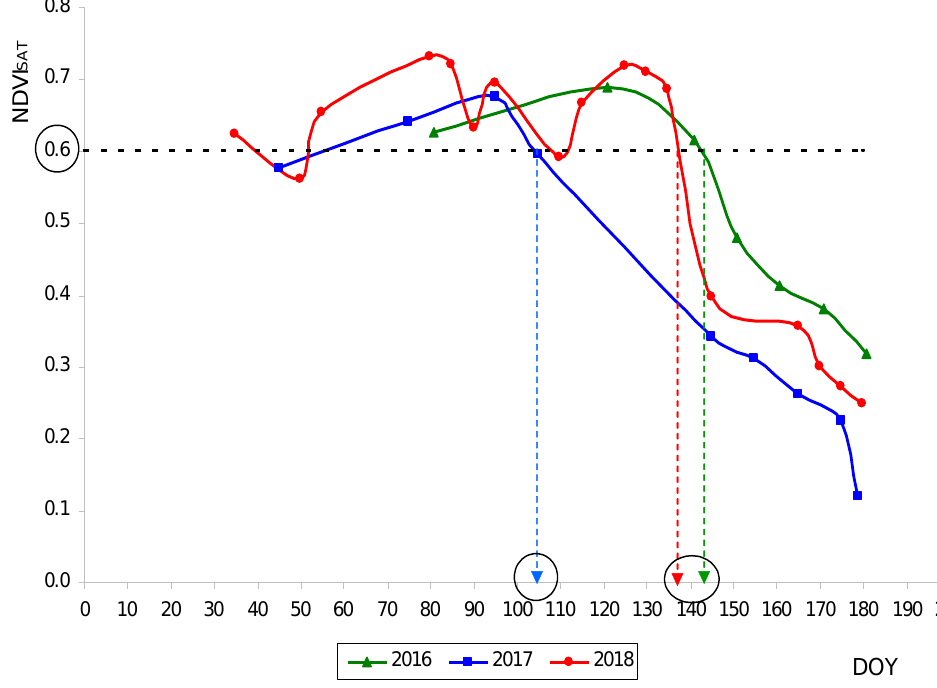
Figure 6. Reconstruction of historical vegetation index trends using time series records of satellite images (NDVI SAT ), retrieved between February and June 2016, 2017, and 2018, without the records affected by the existence of clouds. Data are average values of the twelve sampling points. Arrows indicate the moment in which, in each year, the abrupt fall of the NDVI below 0.6 occurs.